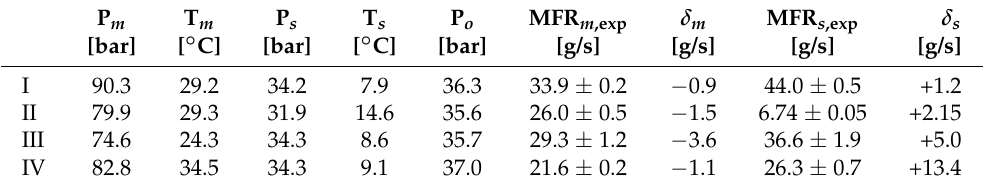
Table 3. Comparison of experimental and CFD results at different operating conditions. δ = MFR CFD − MFR Exp . The MFR measurements are shown with the standard deviation over the experimental measurement period. Subscript exp refers to an experimentally obtained value.